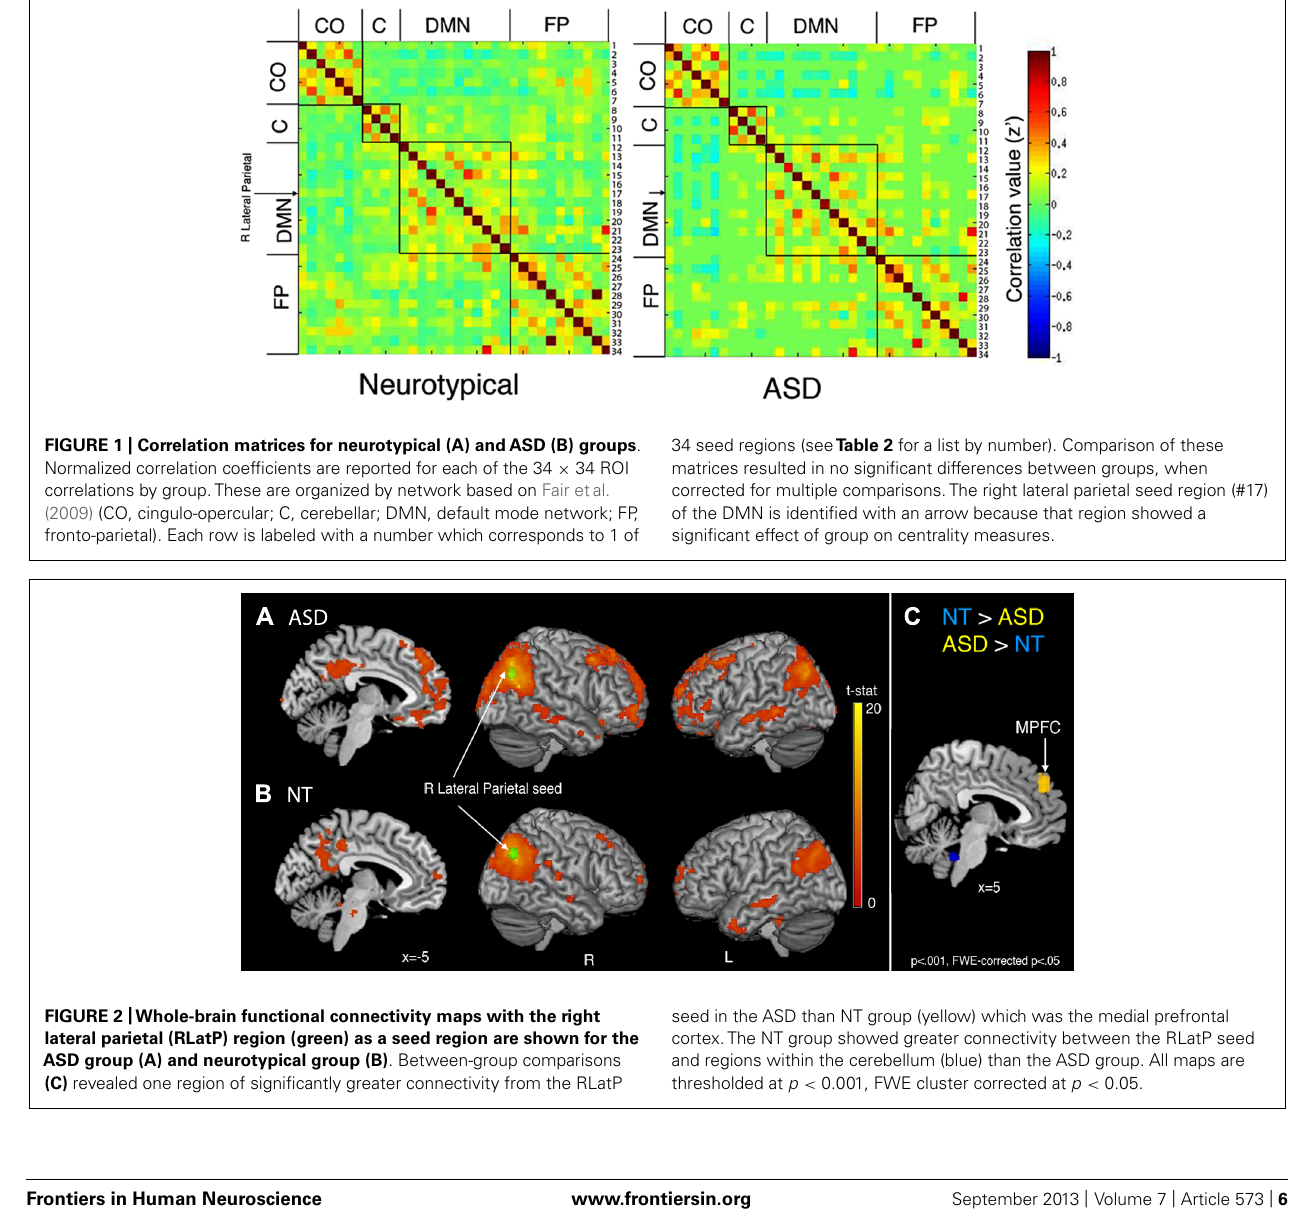
FIGURE 2 |Whole-brain functional connectivity maps with the right lateral parietal (RLatP) region (green) as a seed region are shown for the ASD group (A) and neurotypical group (B) . Between-group comparisons (C) revealed one region of significantly greater connectivity from the RLatP